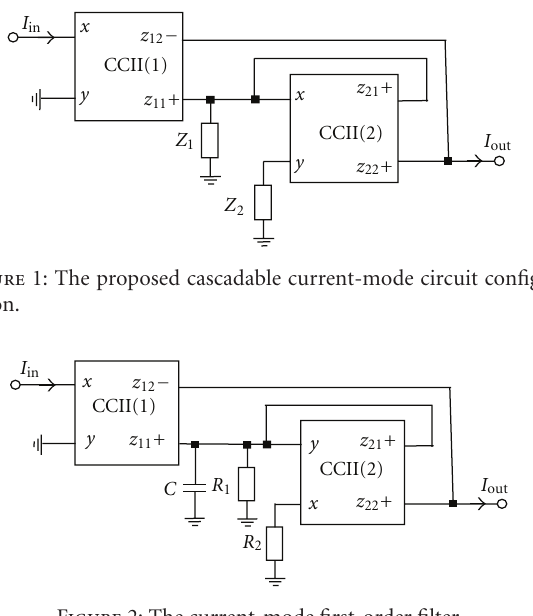
Figure 2: The current-mode first-order filter.